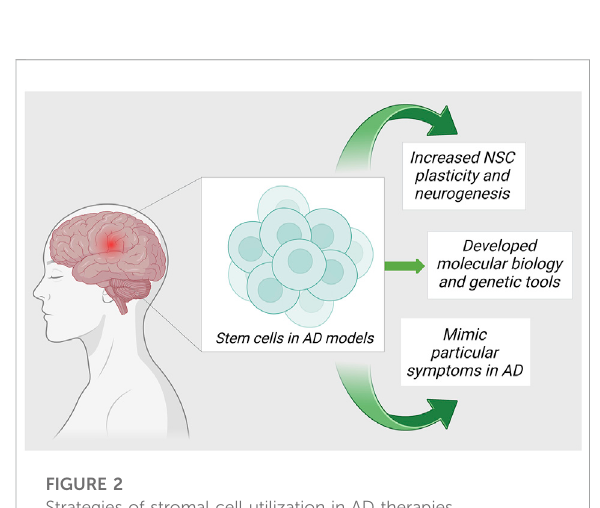
FIGURE 2 Strategies of stromal cell utilization in AD